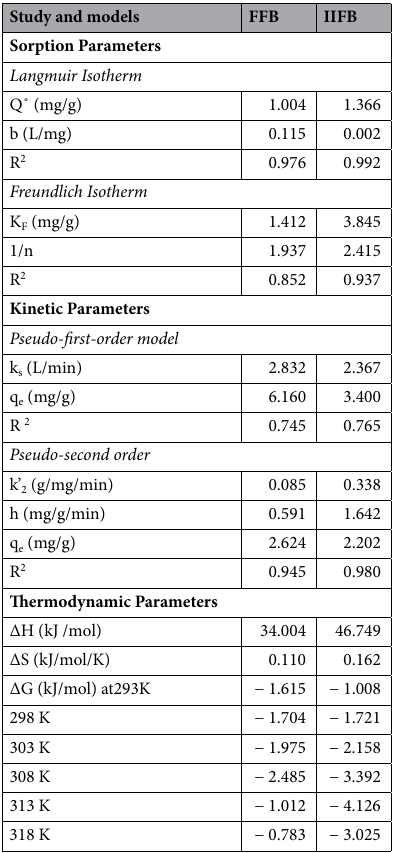
Table 4. Parameters and model constants for isotherm, kinetic and thermodynamic studies for As(III) biosorption over IIFB, here FFB was taken as